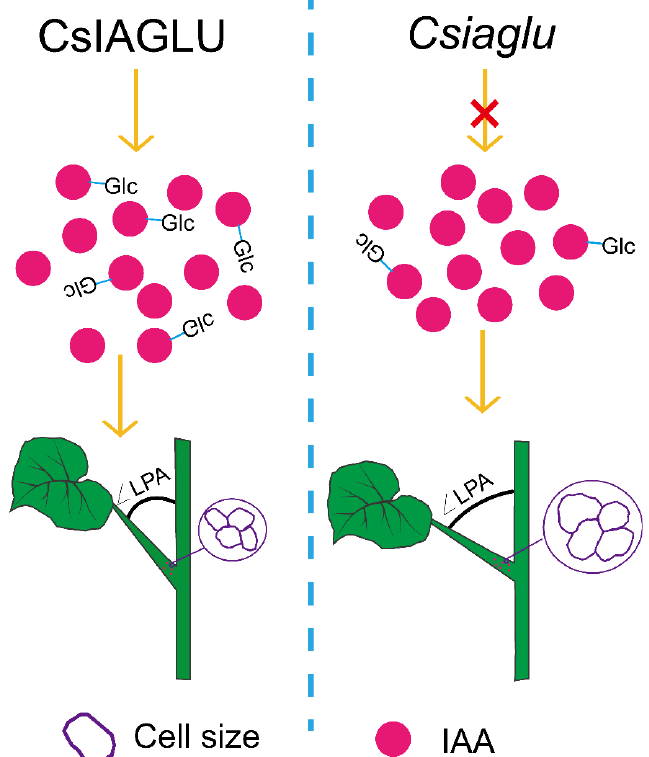
Figure 6. Proposed working model of CsIAGLU influence on cucumber LPA through regulating IAA concentration. CsIAGLU regulates endogenous IAA level by catalyzing free IAA to produce IAA-Glc. However, the increase in endogenous IAA concentration promotes the enlargement of adaxial cells at the petiole base, leading to a greater LPA.